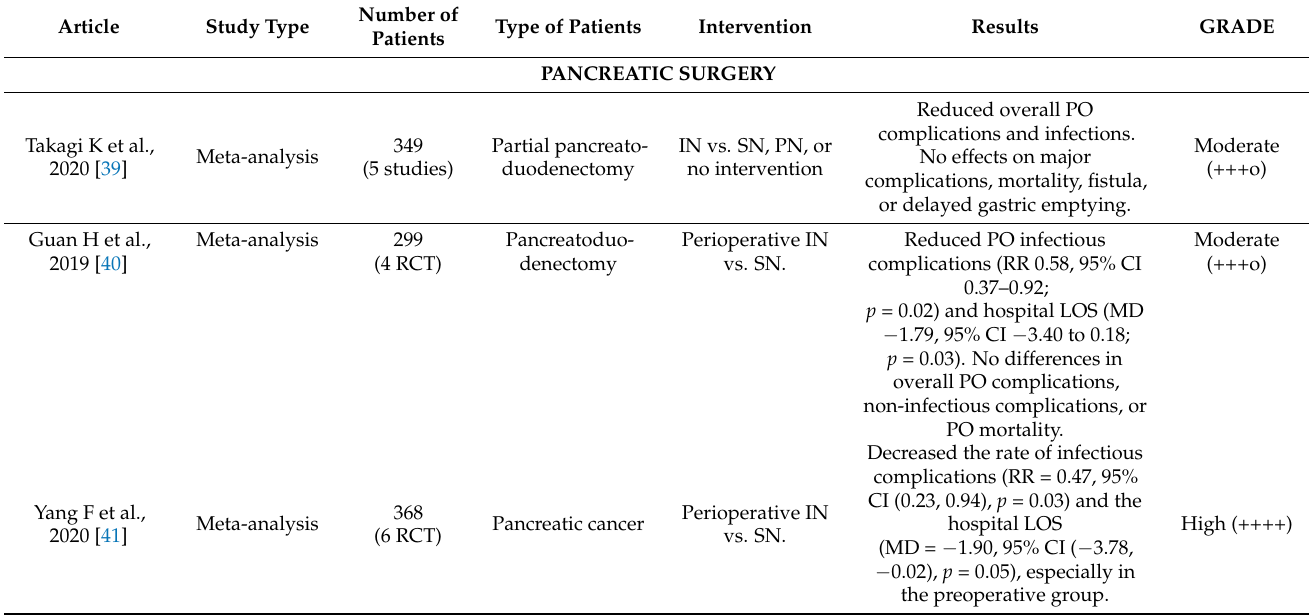
Table 8. Summary of the evidence obtained based on the search strategy and selection of articles with evidence rating using GRADEpro for pancreatic surgery. IN: immunonutrition; SN: standard nutrition; ONS: oral nutrition supplement; PO: postoperative; LOS: length of